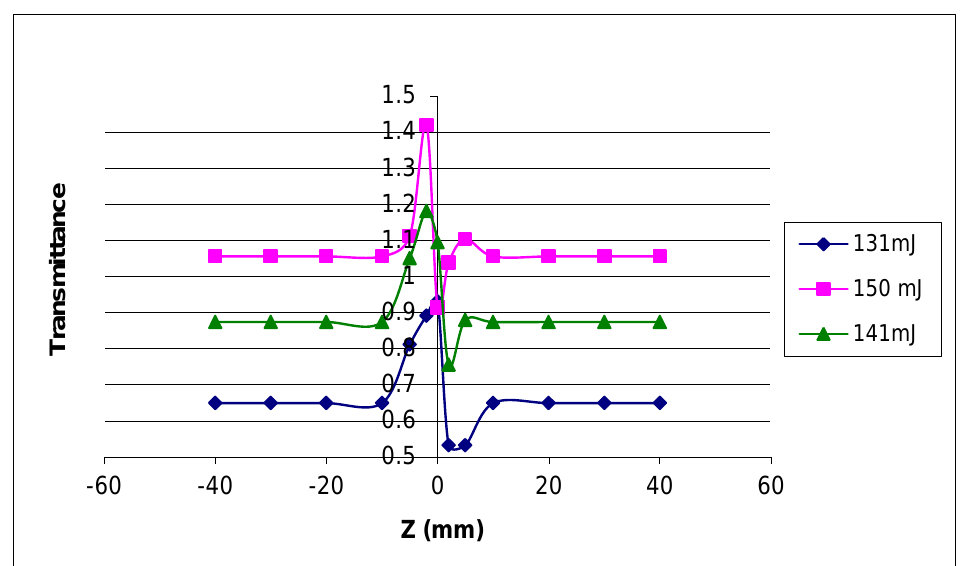
Fig. 1: UV-Vis absorption spectrum of RB dye and TiO polymer.